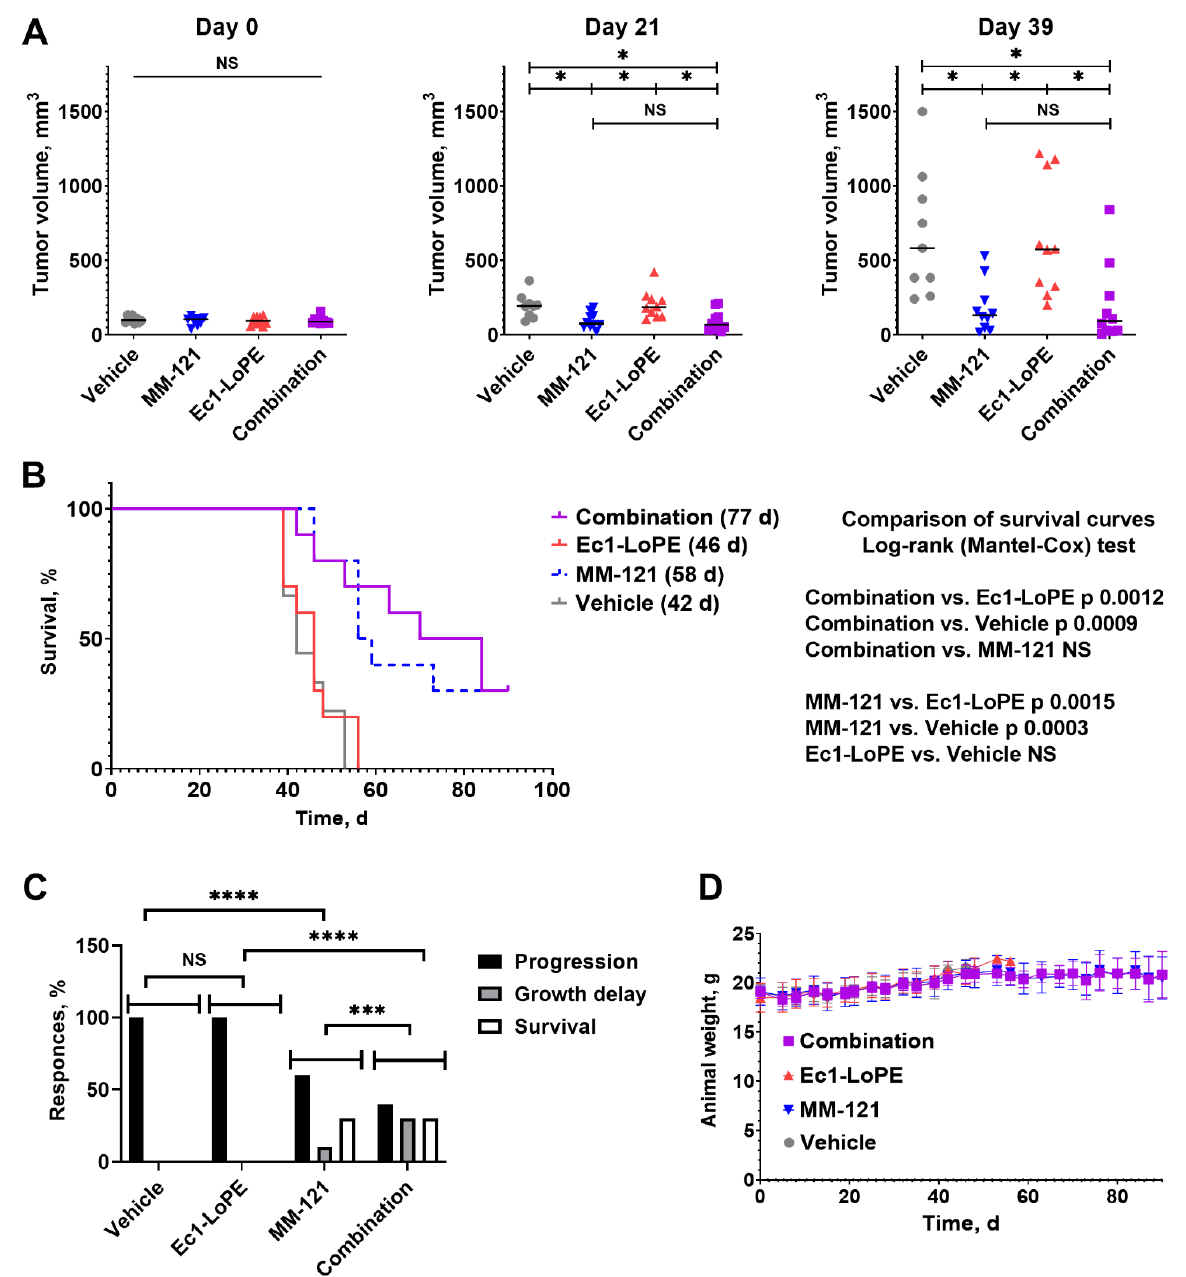
Figure 5. Experimental therapy in BALB/c nu/nu mice bearing BxPC3 xenografts receiving Ec1–LoPE and MM-121 combination treatment, Ec1–LoPE single treatment, MM-121 single treatment, or vehicle (0.9% NaCl). ( A ) Comparison of average tumor volumes at the start of the experiment (day 0), at the start of the second treatment cycle using Ec1–LoPE (day 21), and eight days after the last treatment cycle (day 39). NS corresponds to no statistically significant difference ( p > 0.05), * corresponds to p < 0.05 (one-way ANOVA with Bonferroni correction). ( B ) Survival of the mice during experimental therapy. ( C ) Therapy outcomes for different treatment groups. The outputs categories were defined as progression (exponential tumor growth), growth delay (initial growth suppression followed by exponential tumor growth), and survival (animals did not reach a humane endpoint at the study termination). The difference between groups was determined using the chi-square test. NS corresponds to no statistically significant difference ( p > 0.05), *** corresponds to p < 0.001, **** corresponds to p < 0.0001. ( D ) Average animal weight in each group during the therapy experiment. The data are presented as an average value ±